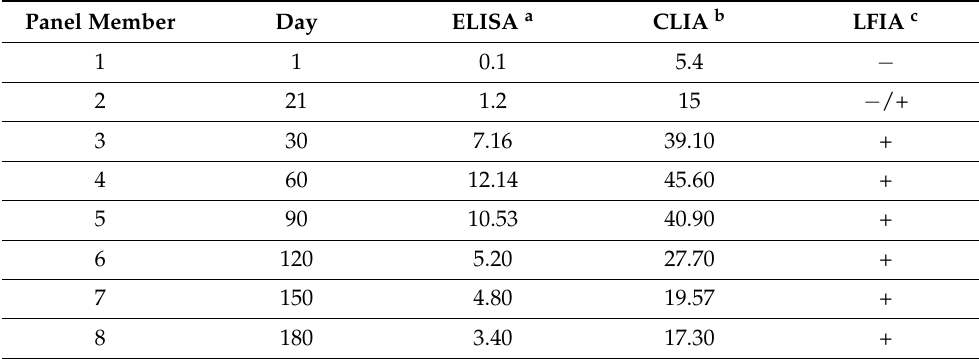
Table 3. The results of the seroconversion panel. Panel Member